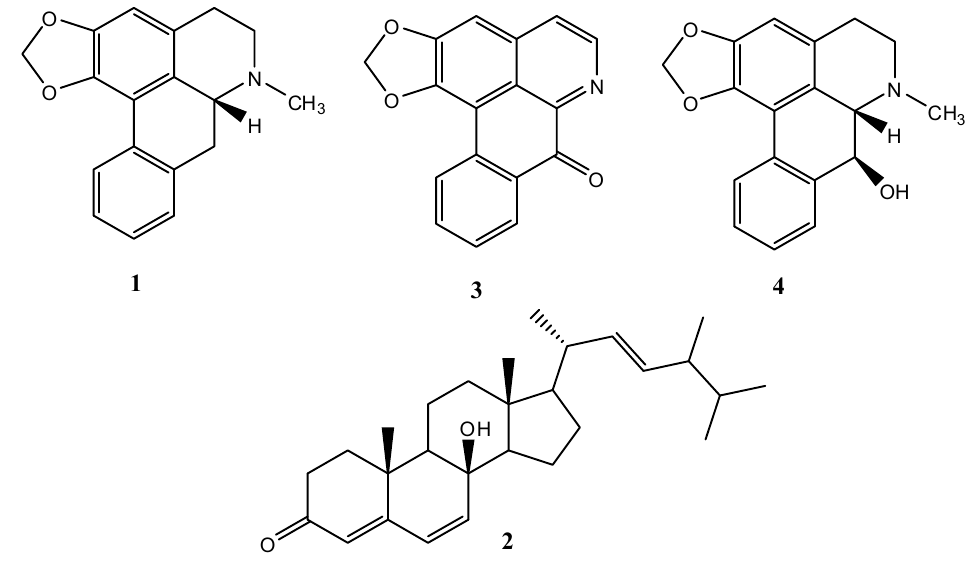
Figure 1. Structure of compounds 1 – 4